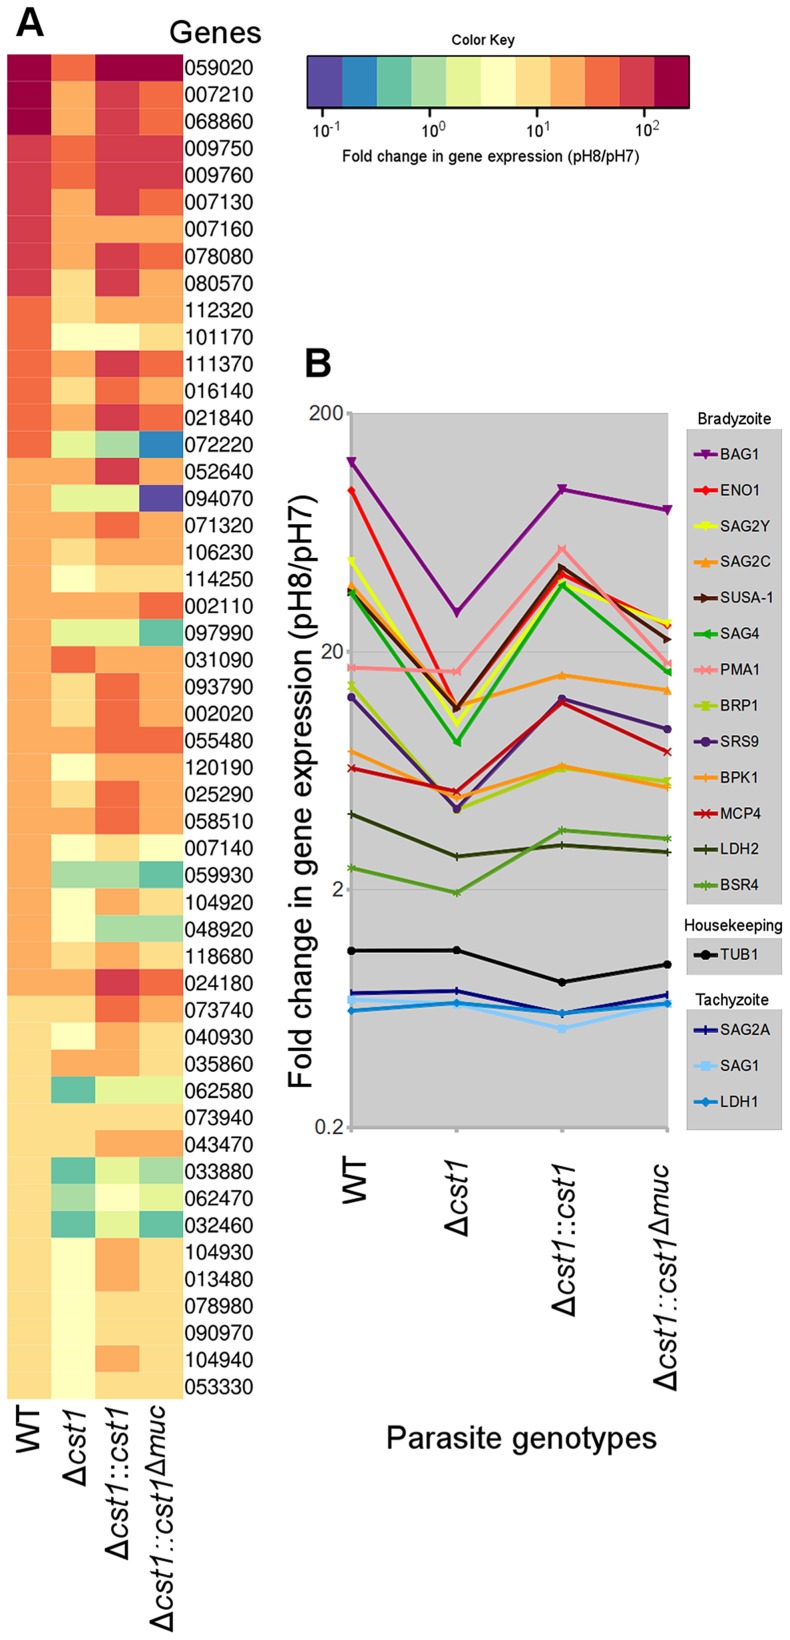
Lack of CST1 reduces bradyzoite gene expression.(A) Heat map of fold change in gene expression (pH 8/pH 7) of wild type and cst1 mutants. The top 50 upregulated genes in wild type T. gondii are displayed in order. The number is the gene name in TGME49 (ToxoDB ver 6.1). Gene upregulation is reduced in the Δcst1 strain. The full length complement strain Δcst1:cst1 has a restoration of gene upregulation to control (WT) levels, but the mucin-null complement strain Δcst1:cst1
Δmuc did not have restoration of these gene levels. (B) Upregulation of known bradyzoite specific gene expressions shows the same pattern. Note that the housekeeping and tachyzoite specific genes did not follow the same expression pattern. Both (A) and (B) graphs were generated from the same RNA-seq data set.